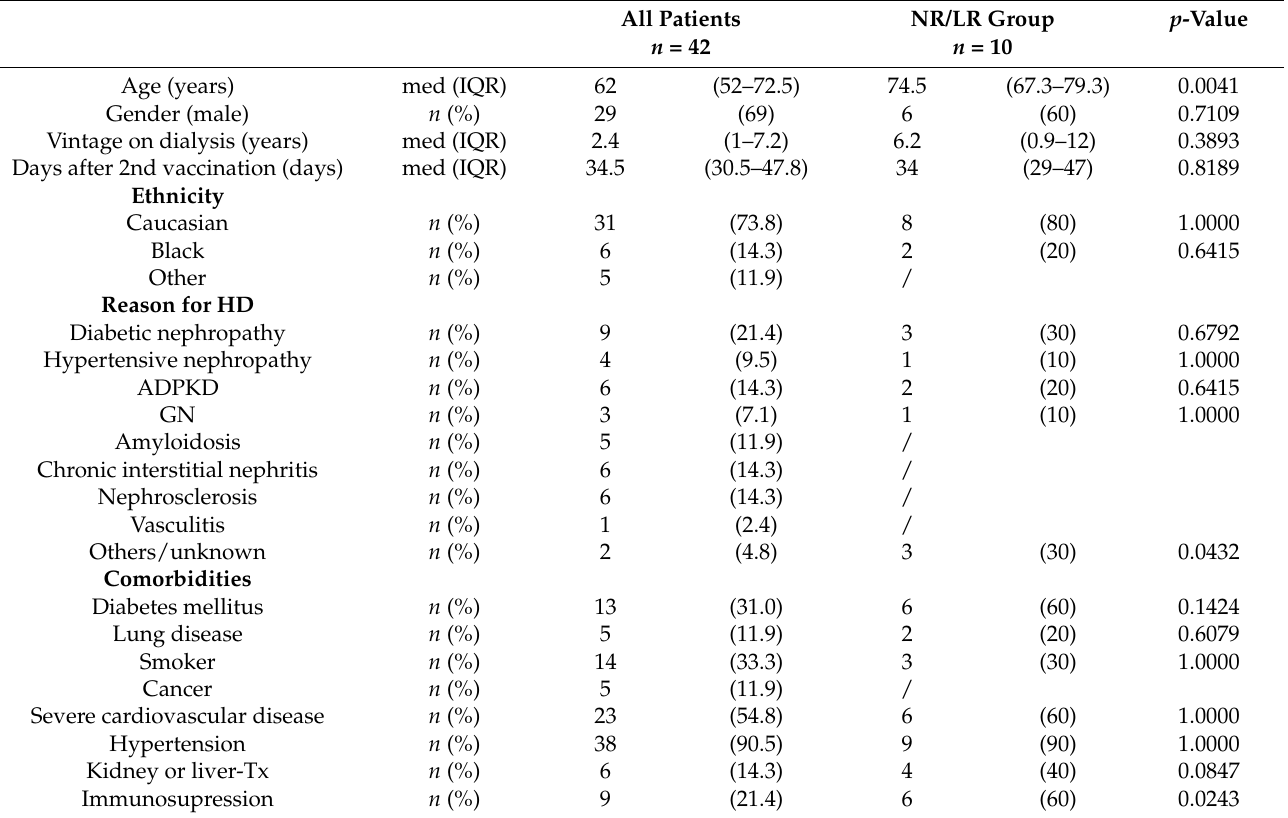
Table 1. Baseline patient characteristics. NR/LR (no response/low response) group with insufficient humoral response after two doses of SARS-CoV-2 vaccine (t 0 ). Abbreviations: m (male); GN (glomeru- lonephritis); ADPKD (autosomal dominant polycystic kidney disease); Tx (transplant). Data expressed as number ( n ) and percentage (%) or median (med) and interquartile range (IQR),